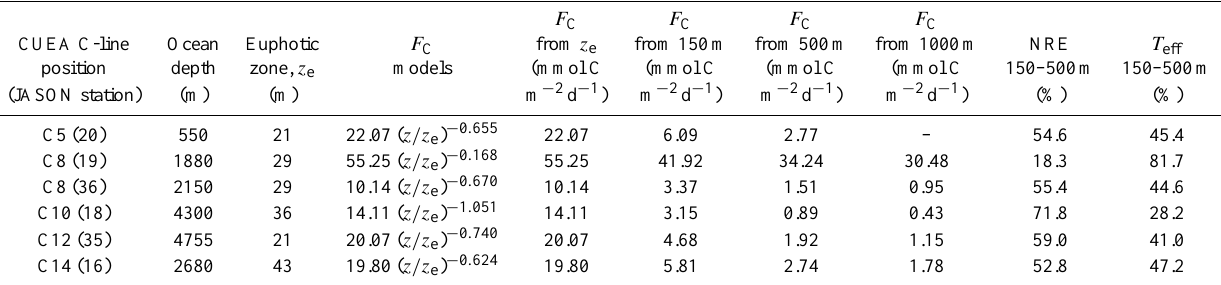
Table 6. Carbon flux models F C at C-line positions deeper than 500m in the Peruvian upwelling system in Sep 1976. From these models, F C at four different depths were determined. NRE and F C transfer efficiency ( T eff ) for the upper mesopelagic waters (150–500m) are also /F c given. NRE was calculated as 100 × R CO , where the R CO represents the integrated R between 150 and 500m; T eff was calculated 150 2 2 /F C as 100 × F C according to Buesseler et al. (2007). 500 150